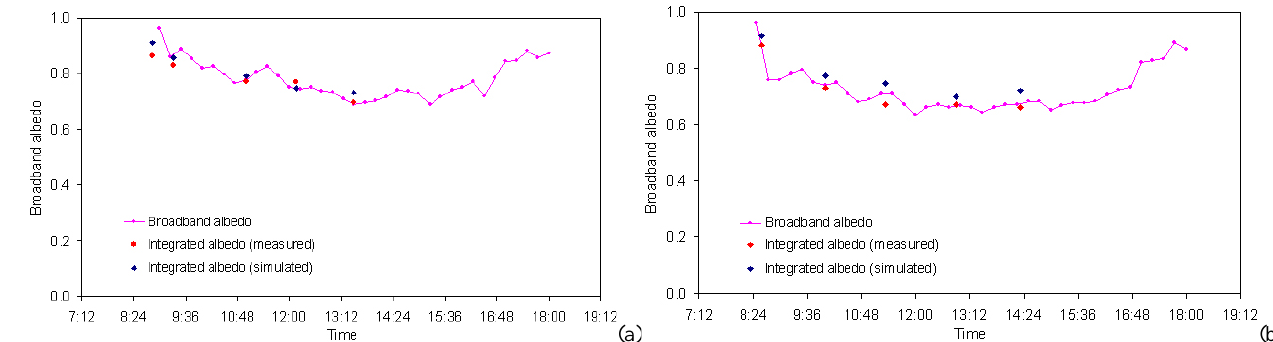
Fig. 7. The comparison between integrated albedo (measured: directly from field spectroradiomenter and, simulated: ART retrieved albedo from reflectance measurement) and field measured broadband albedo: (a) day 1 after snowfall 27 February 2006, (b) day 2 after snowfall 28 February 2006.